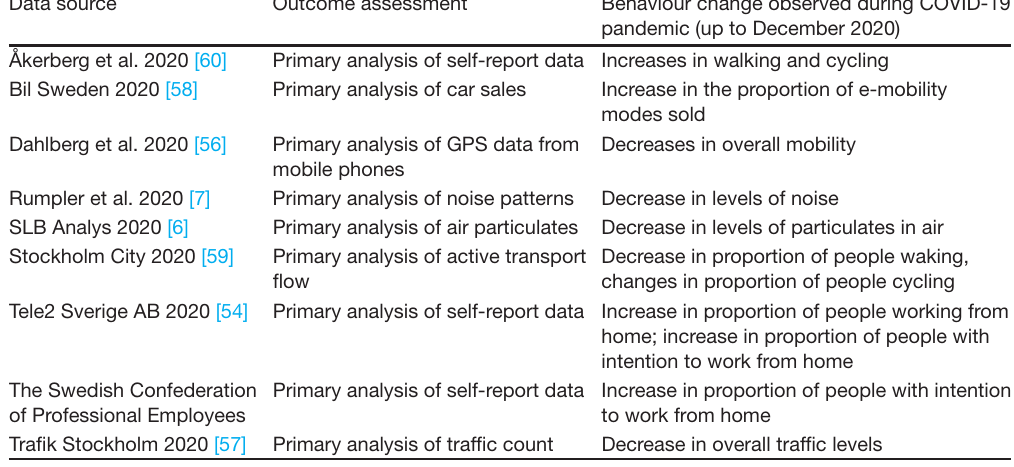
Table A2. Data sources for the Swedish case Data source